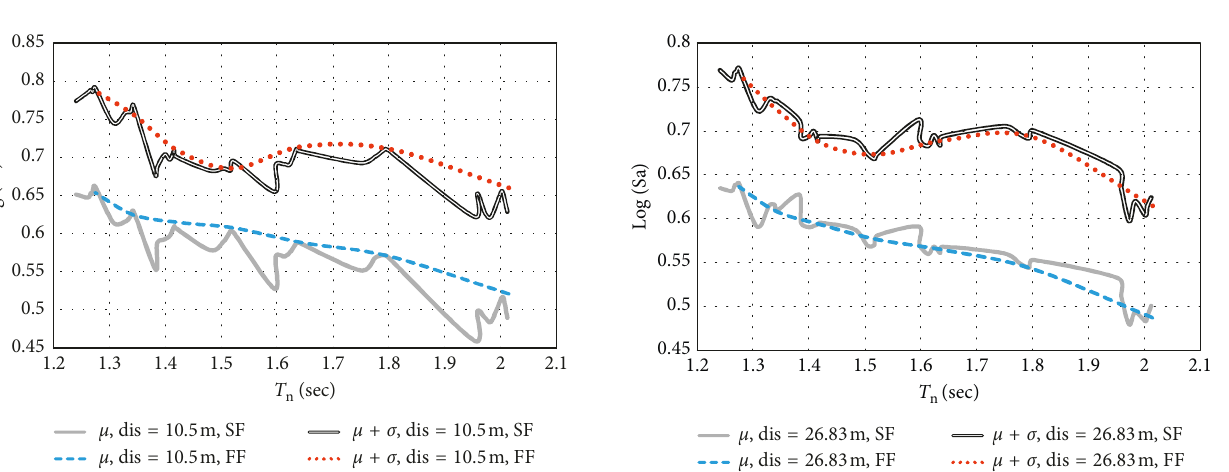
Figure 7: Mean and μ + σ for log of the spectral acceleration for modelsinthepresence(SF)andabsence(FF)ofatunnel atadistanceof 10.5mfromthecenterofthetunnelprojectionontothegroundsurface.